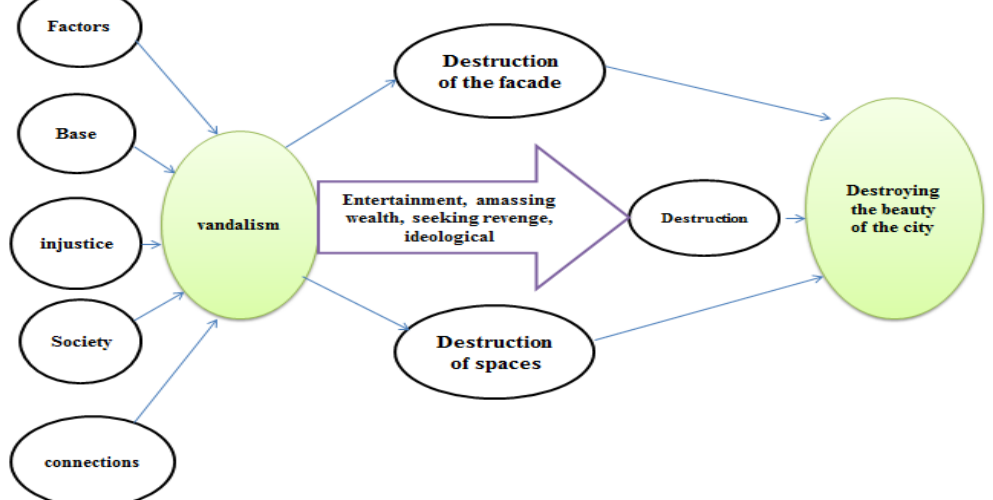
Fig.1: Conceptual model of research Fig. 1: Conceptual model of